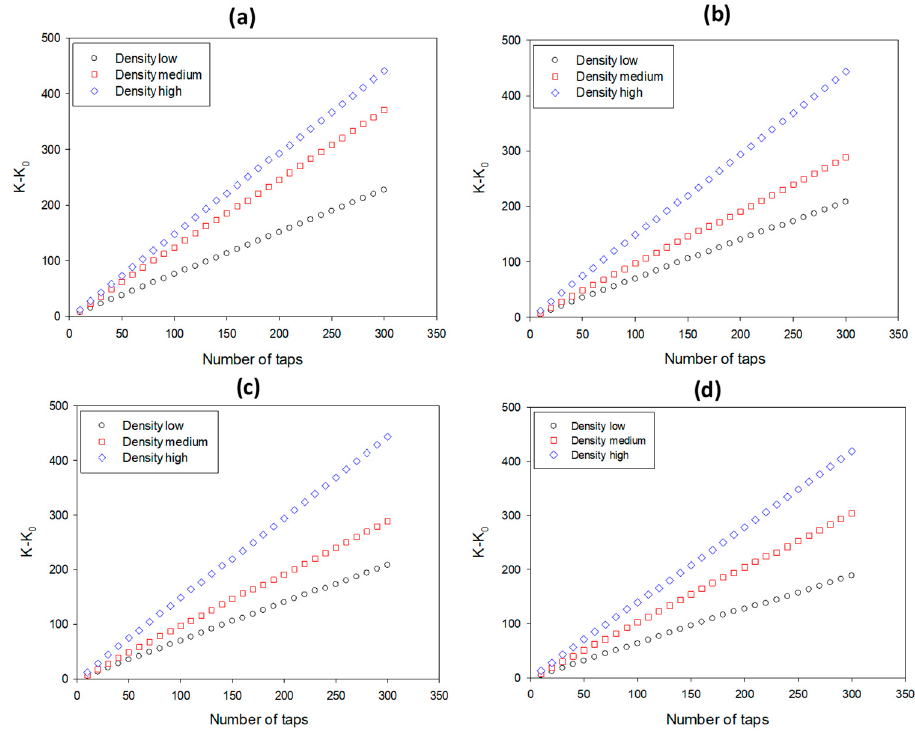
Figure 4. Varthalis–Pilpel plots for: ( a ) small/plain, ( b ) large/plain, ( c ) small/coated, and ( d ) large/coated pellets.